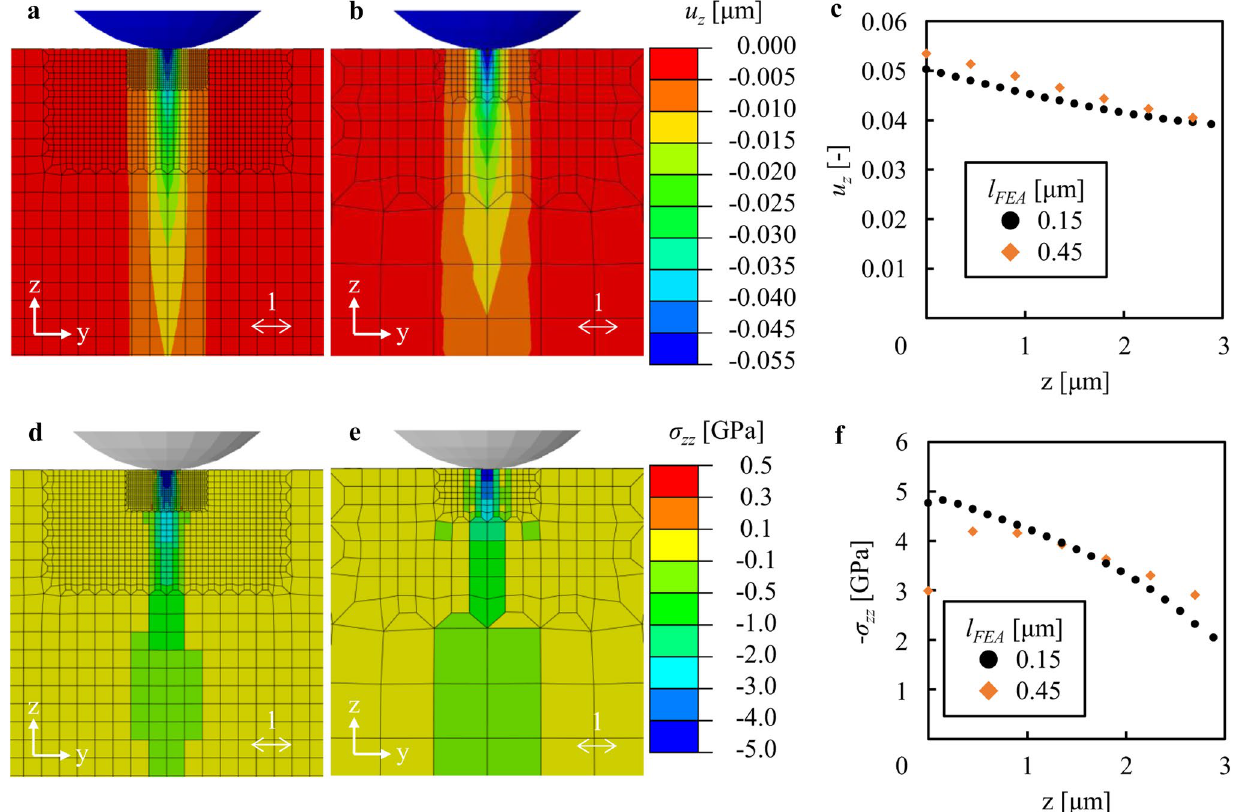
) and normal stresses ( σ z